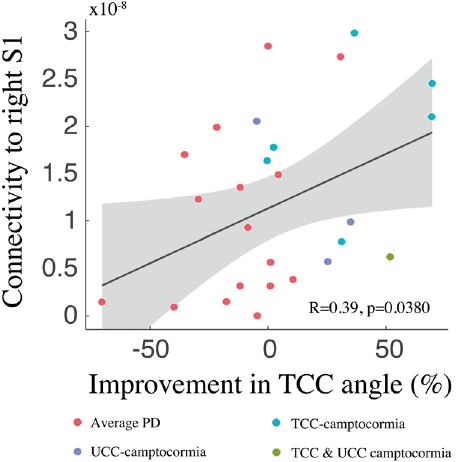
Fig. 6 Signi fi cant correlation was found between structural connectivity from VTA to right S1 and percent improvement in TCC angles. Gray areas represent the 95% CI. PD: Parkinson ’ s disease; S1: somatosensory cortex; PD: Parkinson ’ s disease; TCC: total camptocormia; UCC: upper